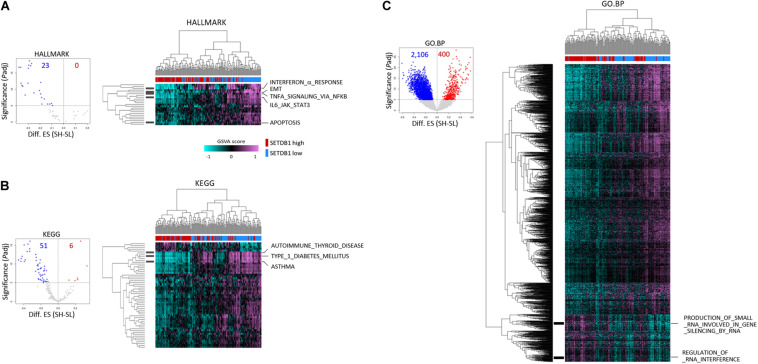
Single sample gene enrichment analysis (GSEA) with gene sets showing differential enrichments in SETDB1-high (SH) and SETDB1-low (SL) lung adenocarcinoma samples. Using GSVA, single sample GSEA was performed on three gene collections from MSigDB (v7.0): HALLMARK (A), KEGG (B), and GO:BP (C). Volcano plot shows the distribution and the number of gene sets with differential enrichments (DE; FDR < 1 × 10– 5) between the SH and SL samples in each collection; each dot indicates a gene set in selected MSigDB collections. In the plot, x-axis designates the difference (SH-SL) of enrichment scores between SH and SL and y-axis represents the significance of DE scores; red and blue dots indicate gene sets that are enriched and depleted in SH samples, respectively. Heatmaps show the differential enrichments among individual SH and SL samples. Samples are hierarchically clustered on x-axis (SH, red; SL, blue), and significant DE gene sets are shown on y-axis. Black bars on the left represent the gene sets mentioned in Figure 3, and the names of the gene sets are denoted on the right. Colors in GSVA score bar indicate enrichment scores in individual samples.